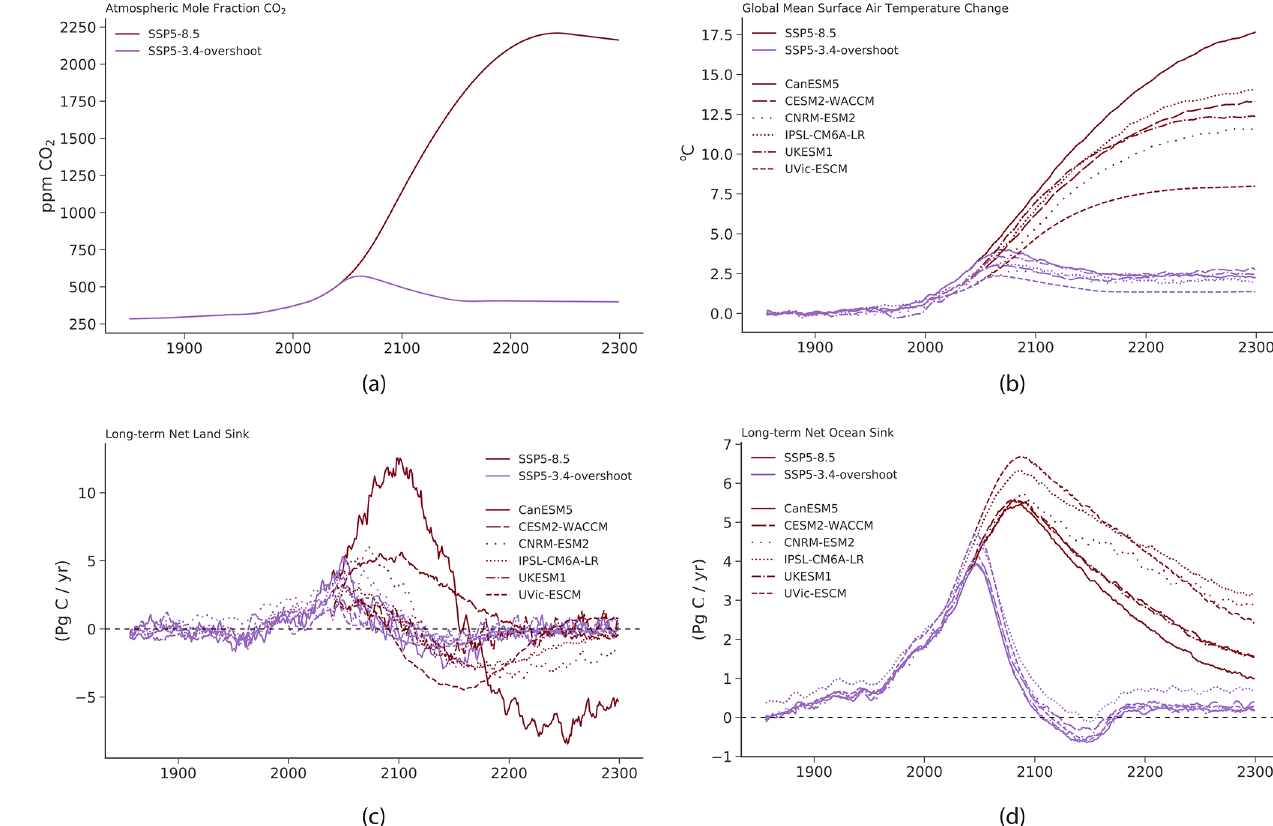
Figure 1. (a) Atmospheric CO 2 concentrations for the high-emissions SSP5-8.5 and mitigated SSP5-3.4-overshoot scenario out to 2300. (b) Global mean surface air temperature. (c, d) Long-term dynamics, as projected by five ESMs and one EMIC, of (c) the terrestrial carbon cycle and (d) the ocean carbon cycle for both scenarios. All time series are smoothed to give 7-year running means, and positive flux represents a carbon sink into the land or